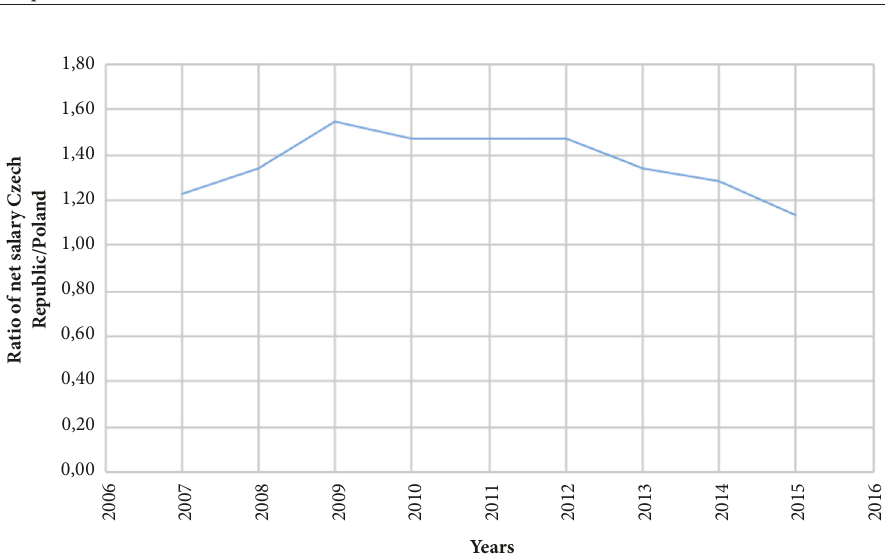
Figure 5: Ratio of net salary in the Czech Republic and in